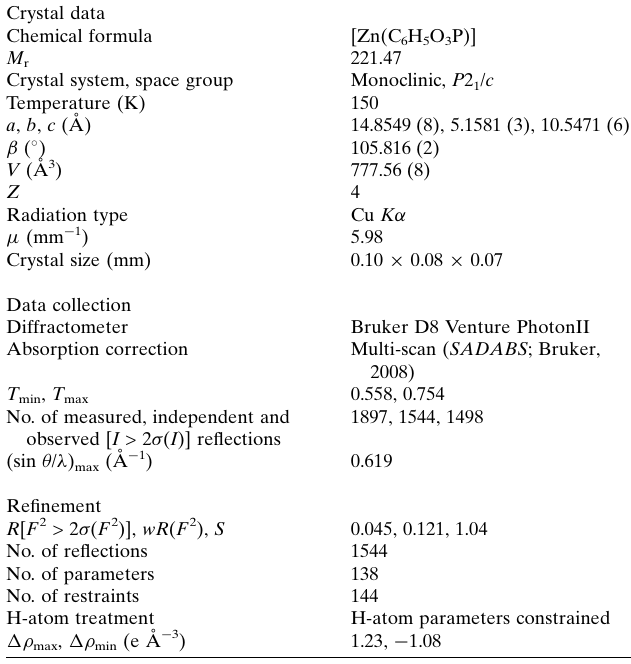
Table 1 Selected bond lengths (A˚ ).